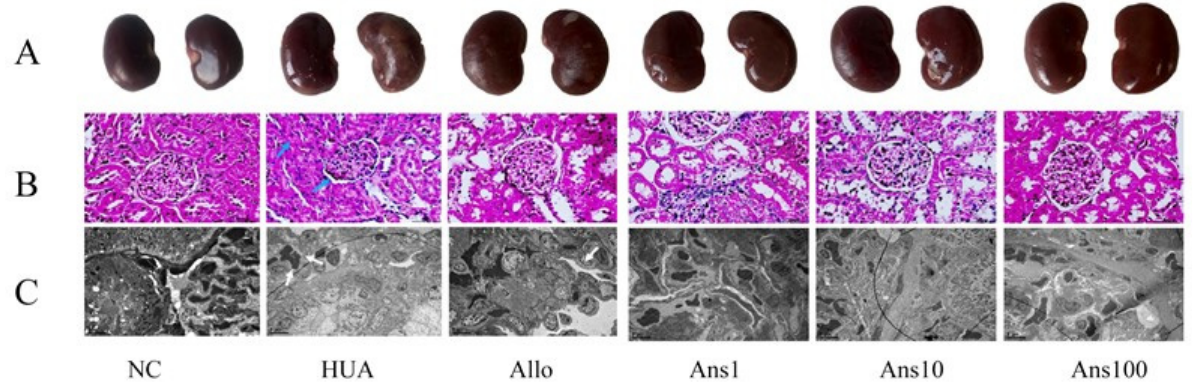
Figure 3. Morphological observation of anserine on kidney pathological damage caused by hyperu- ricemia. Morphological pictures of different groups of kidneys were observed: ( A ) naked eyes, ( B ) light microscopy and ( C ) electron microscopy.